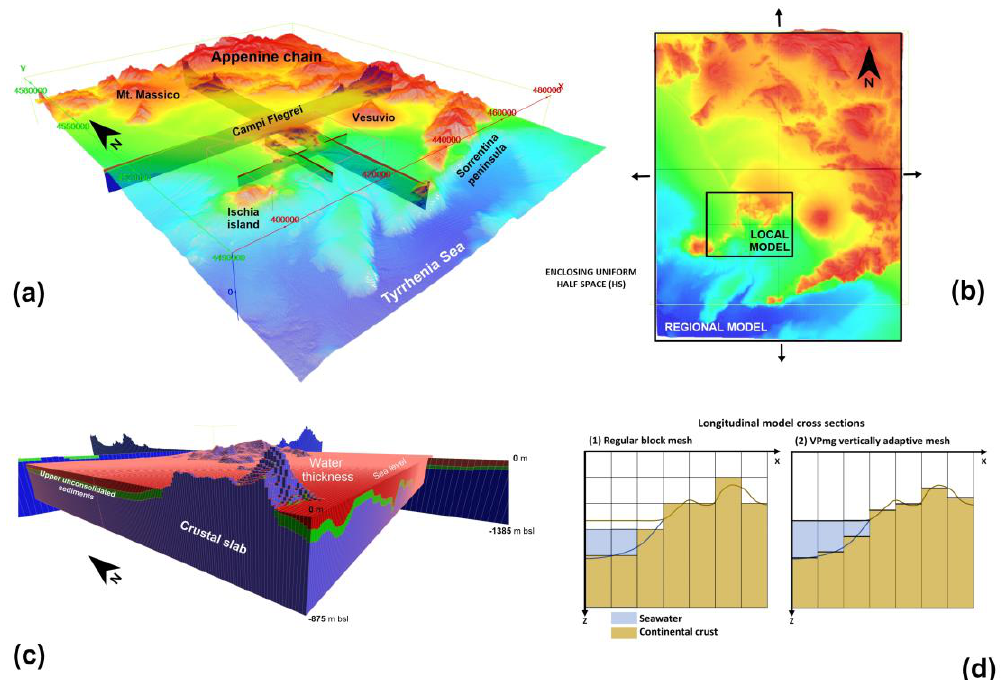
Figure 5. Orthogonal 3D cross sections of the two nested CFc and CP topographic models used for the VPmg TGE computation with the regional DEM in transparency ( a ). Extension of the regional and local area onto the DEM ( b ). Magnification of the local topographic model observed from the SW point of view (Vertical exaggeration is four times). The three volume units of the VPmg model with their prisms are clearly represented ( c ). Schematic draw of the standard block mesh vs. the adaptive VPmg mesh. It is possible to observe the different behavior of the prisms at the air/crust and water/crust boundaries ( d ).